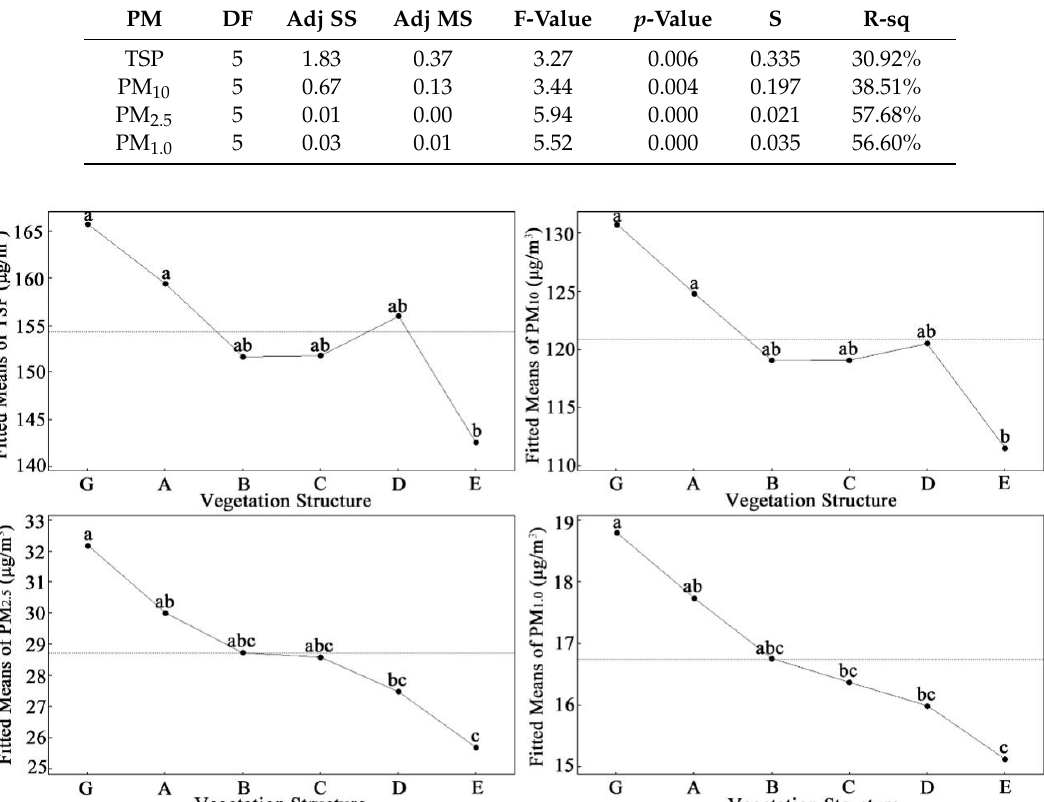
Figure 6. Di ff erences of atmospheric suspended particulate matter concentration in green space with di ff erent vegetation structures. “A” represents open lawn green space, “B” represents semi-open lawn green space, “C” represents semi-closed single-layered broadleaved forest, “D” represents closed single-layered broadleaved forest, “E” represents closed single-layered mixed forest, “G” represents gray space. The lower-case letters in the figure represent the grouping information obtained by multiple comparisons of means using the Tukey method.